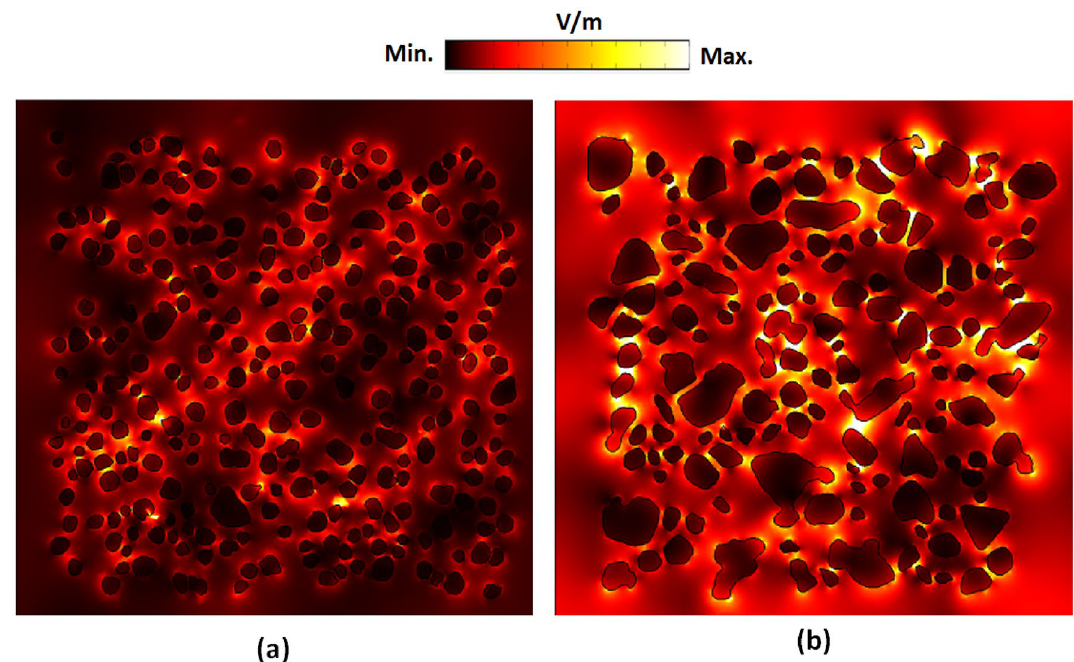
Figure 8. Spatial electric field distribution with an incident wavelength of 650 nm on the fabricated PPE